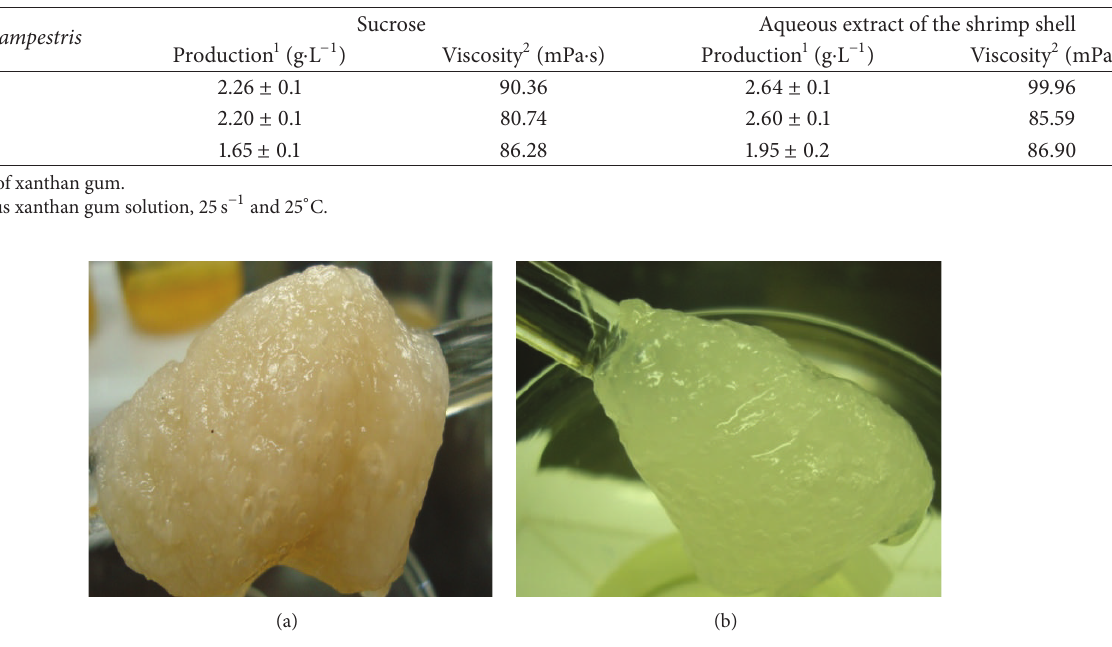
Figure 2: Appearance of the biopolymer produced from the aqueous extract of the shrimp shell (a) and from sucrose (b) precipitated with ethanol.